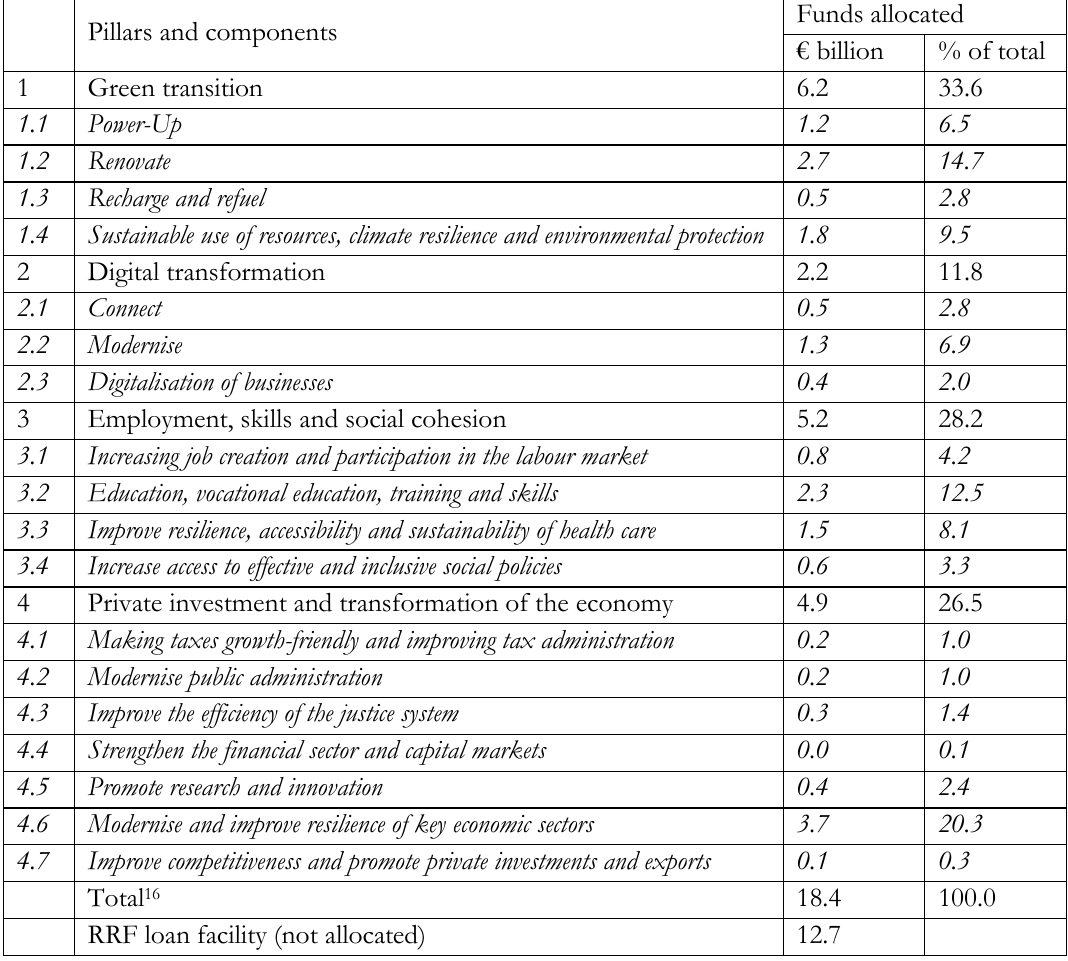
Table 1: Structure of the Greek NRRP Pillars and